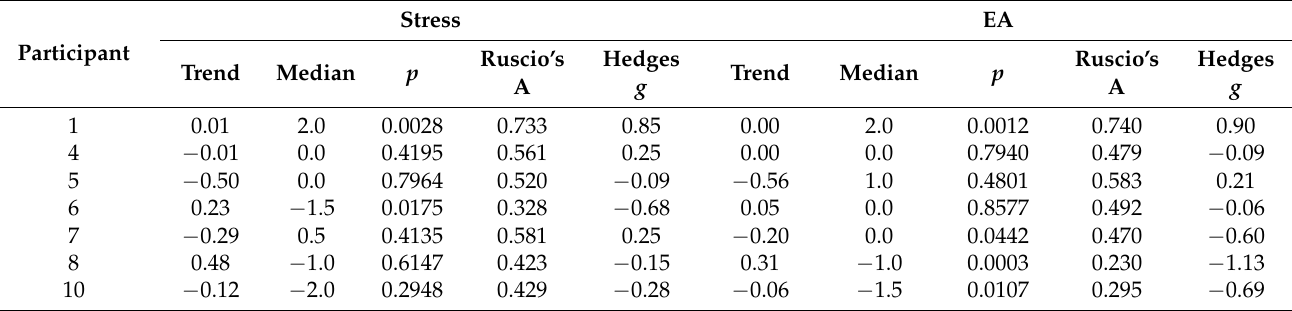
Table 3. SCED quantitative analyses summary for stress and experiential avoidance.